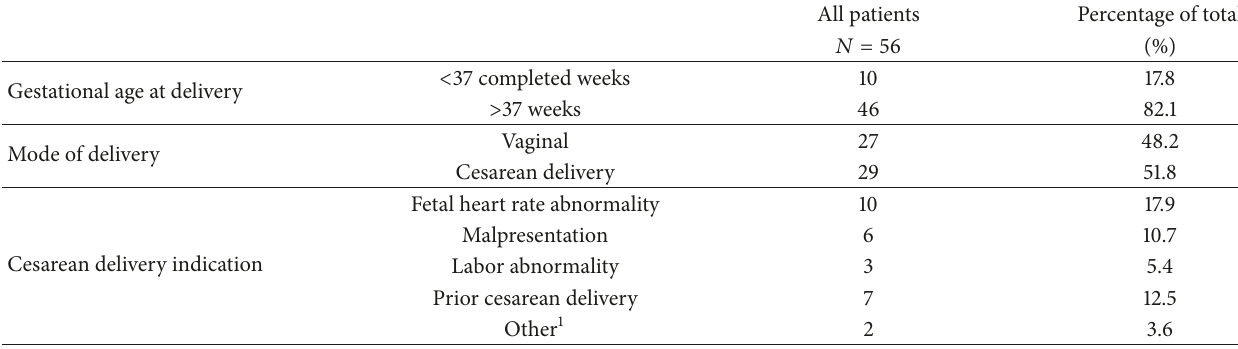
Table 2: Obstetrical outcomes.